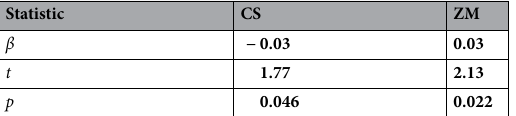
Table 2. Results of multilevel modeling of relationships between continuous valence ratings and facial electromyography data in Experiment 2. There were 22 degrees of freedom, as calculated by the m – l –